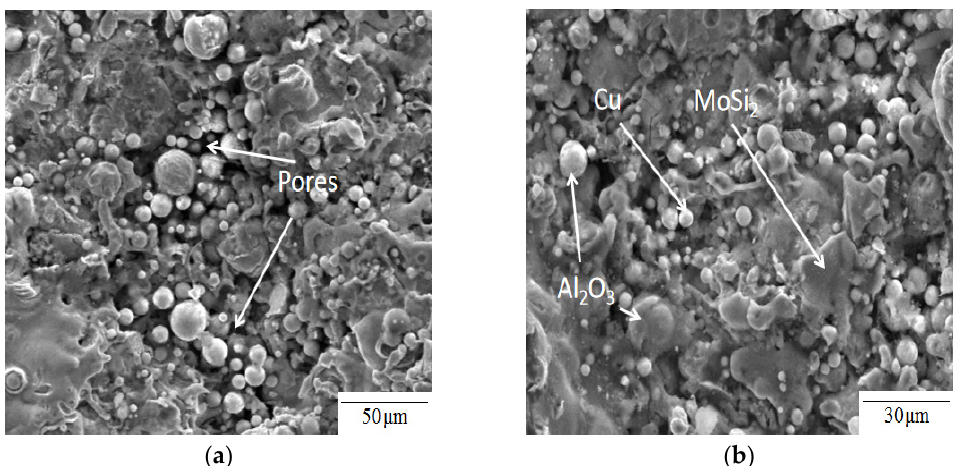
Figure 6. SEM micrographs of the Al 2 O 3 –MoSi 2 /Cu coating upper surface: ( a ) some pores exist in the coating surface ( b ) MoSi 2 , Al 2 O 3 , and Cu particles.